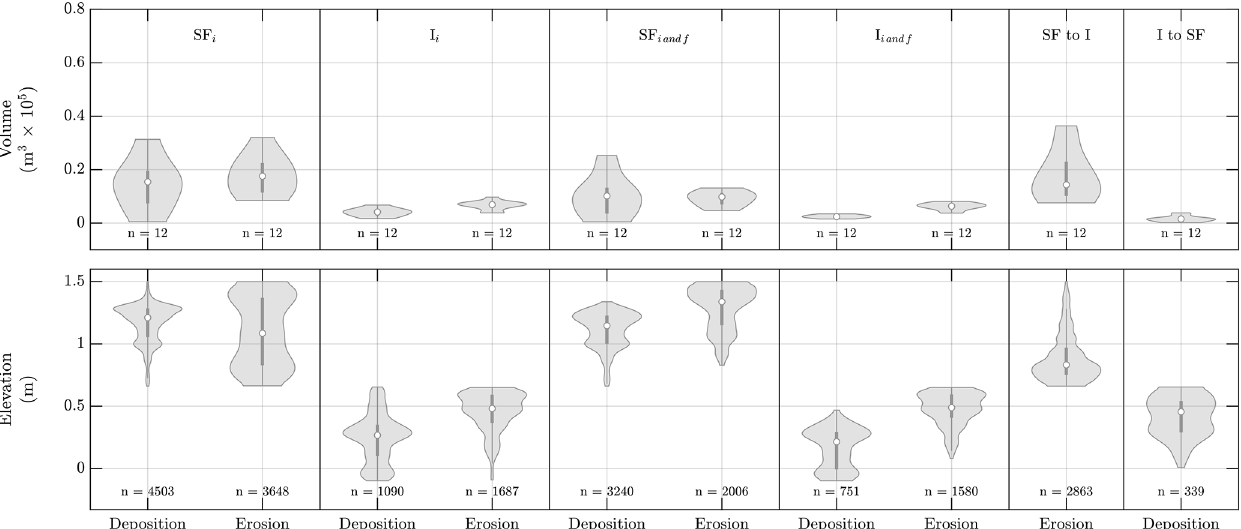
Figure 11. Violin plots showing storm-induced volume changes and the elevation where such changes occurred. Dark grey boxes represent a standard boxplot (i.e. median and quartiles), whereas light grey shapes represent the normalised population distribution of the data plotted in the boxplot. “SF” and “I” refer to “Sand flat” and “Intertidal” zone, respectively. Subscripts “ i ” and “ f ” refer to the boundaries used to estimate each zone that locates the changes. Subscript “ i ” refers to a zone (e.g. SF or I) estimated using the initial contour to set the zone (i.e. before the storm), whereas “ f ” refers to the use of the final contour to estimate the zone (i.e. after the storm). Combination of both leads to a restricted zone estimated using both the initial and final contours (thus zones that did not change over the simulation), whereas using both “SF” and “I” refers to zone that changed to the other during after the